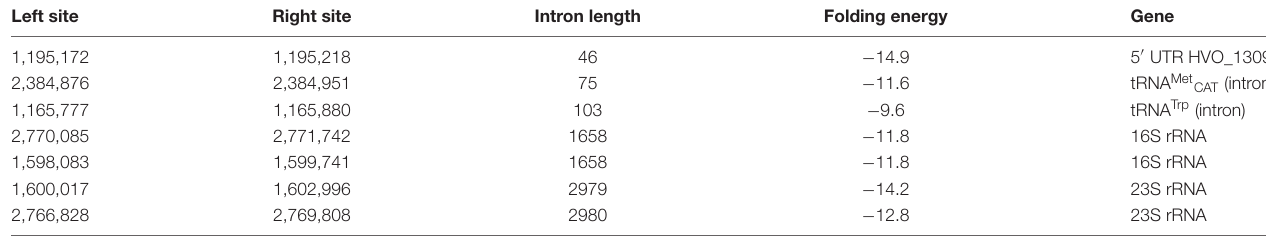
TABLE 3 | Circular RNAs Identified by circRNA-seq. Left site Right site Intron length Folding energy